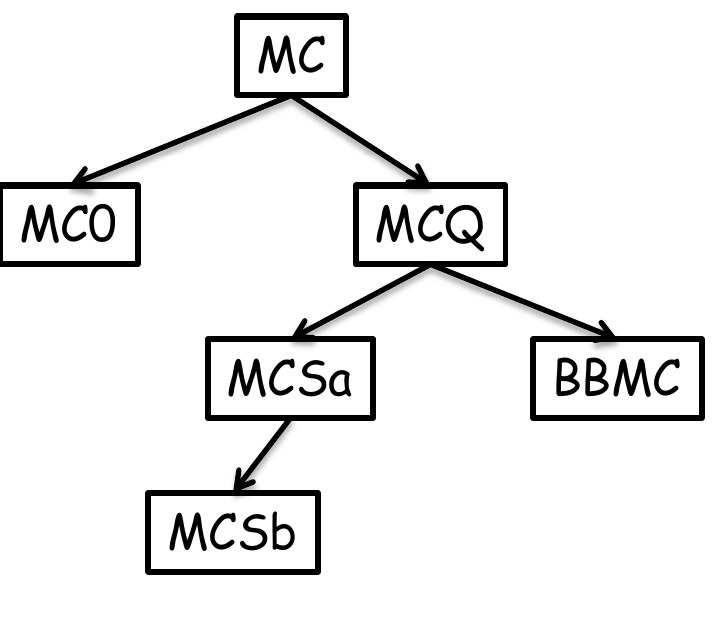
Figure 1. The hierarchy of